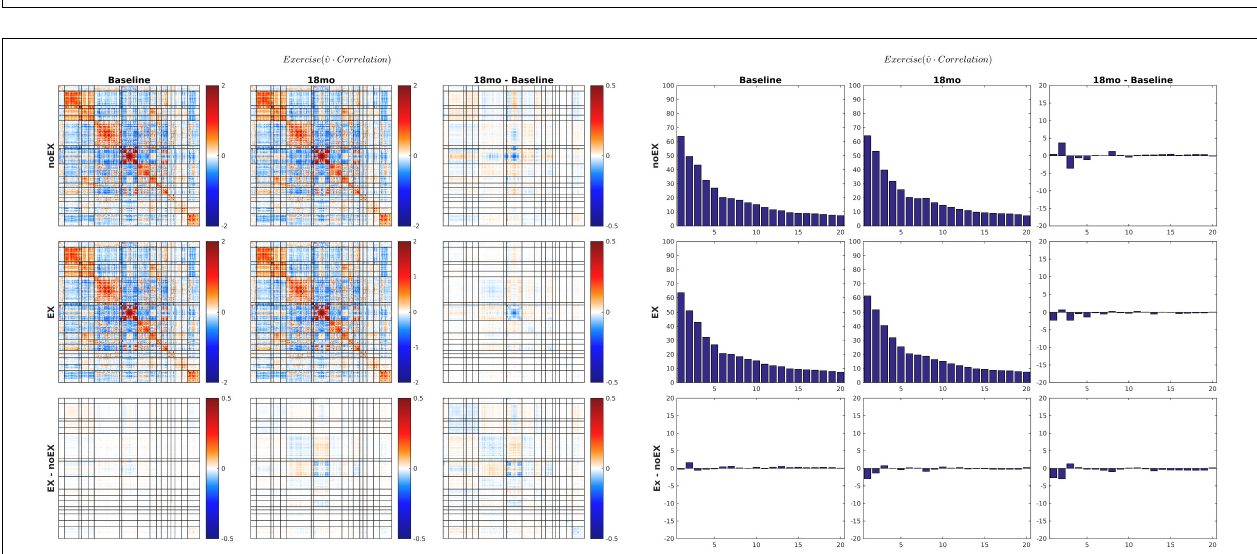
FIGURE 5 | 18-months vs. baseline effect of mindfulness training on covariance FC. Covariance matrices and corresponding covariance component bar plots are shown on the left and right of the figure. The information content of the matrix and bar plot displays is identical. At 18 months vs. baseline, all participants, with or without MBSR training, showed increased activity in visual cortex and the DMN with more pronounced VIS-DMN negative covariance (upper matrices in right column). The 18-month change specific to MBSR was less focal and quantitatively modest (lower matrix in right column). In the notation of Eq. 7, the lower right bar plot represents (cid:49) MBSR − noMBSR (cid:49) vist 3 − 1 (cid:57) . Statistical testing of | (cid:49) MBSR − noMBSR (cid:49) vist 3 − 1 (cid:57) | is illustrated in Figure 7A ( p = 0.03).